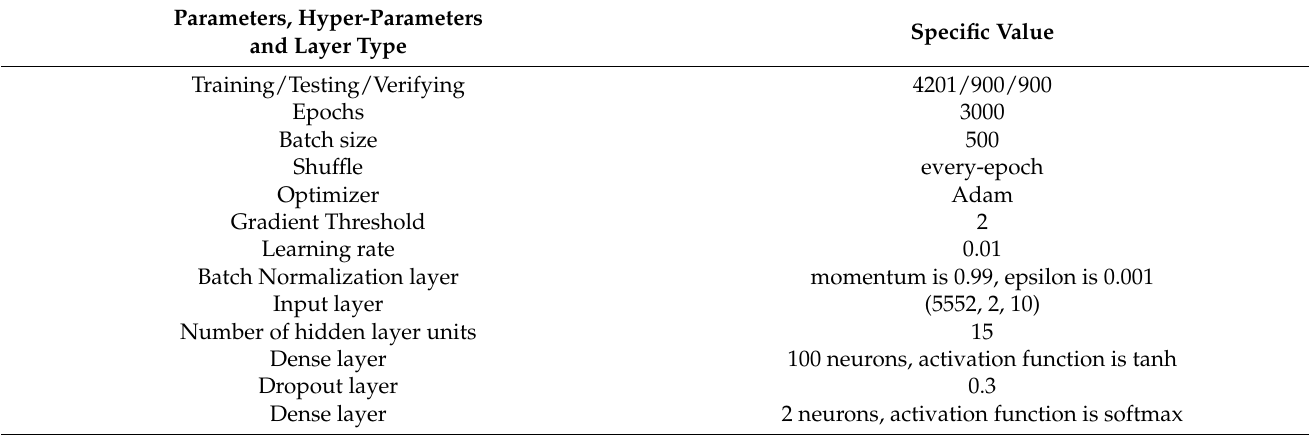
Table 2. LSTM model parameters, hyperparameters, and layer